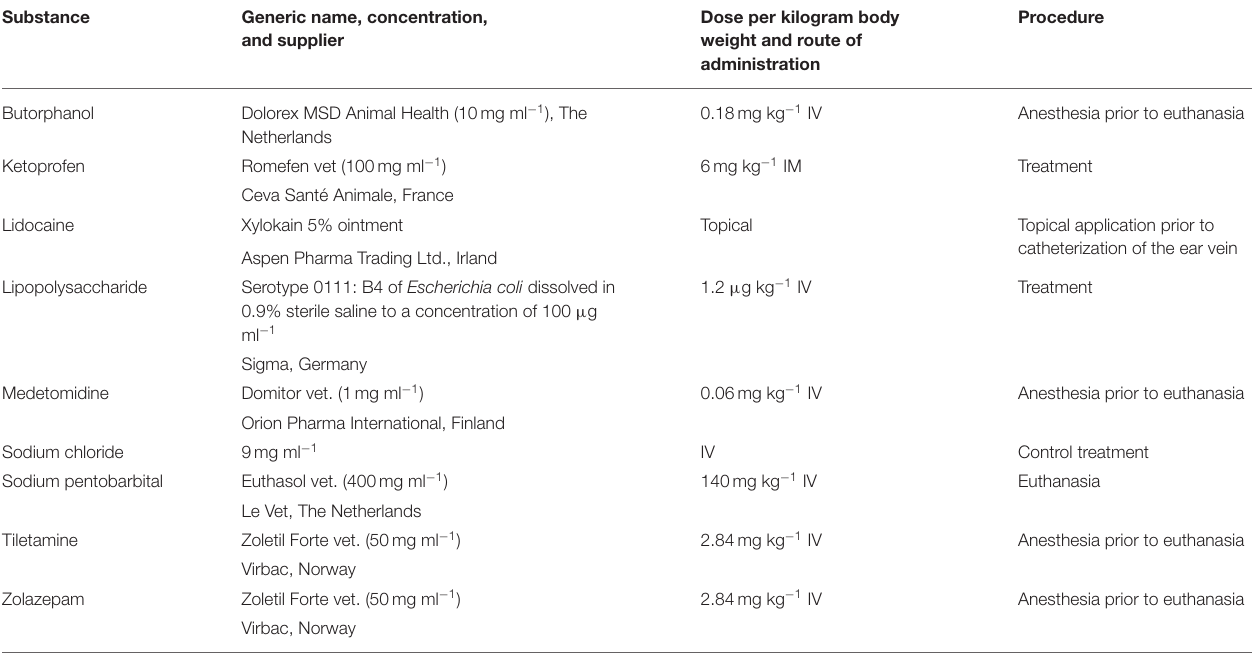
TABLE 1 | Overview of substances used for each procedure, with dose, and route of administration indicated. Substance Generic name, concentration, and supplier